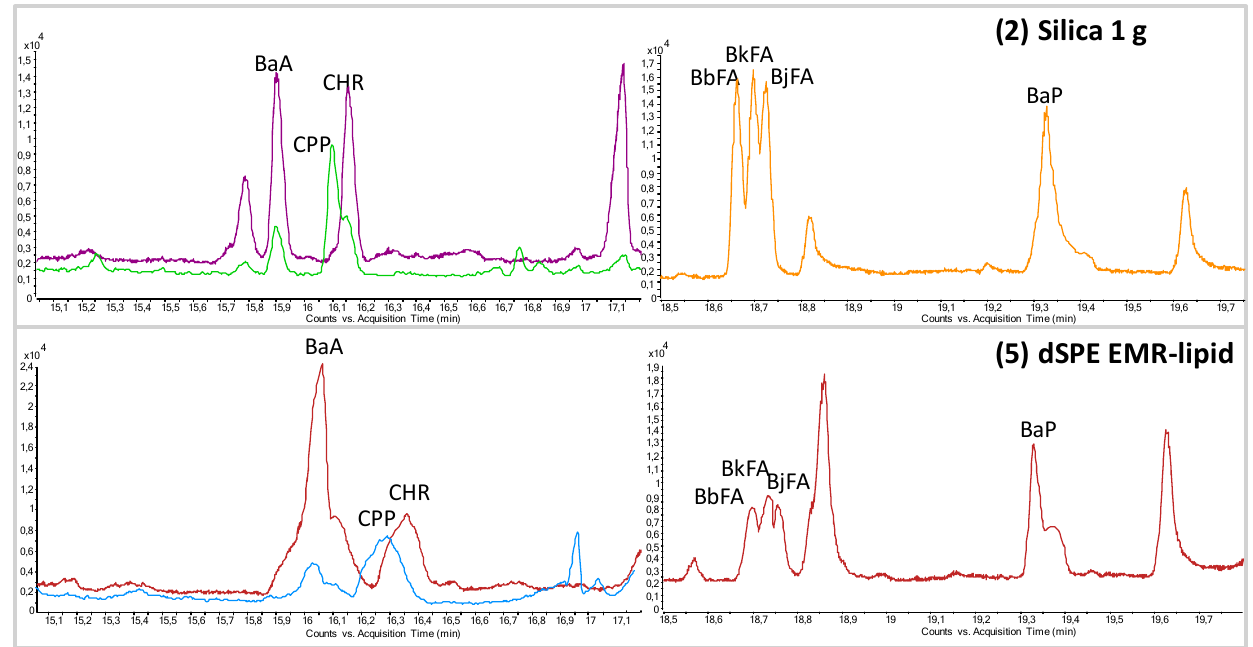
Figure 4. An example of the GC-MS/MS chromatogram in multi reaction monitoring (MRM) mode of a smoked trout sample spiked with PAHs. MeCN extract purified using ( 2 ) silica SPE minicolumn and ( 5 ) dSPE EMR-lipid. MRM transitions shown: CPP-226 > 226; BaA, CHR-228 > 228, BbFA, BkFA, BjFA, BaP-252 > 252.